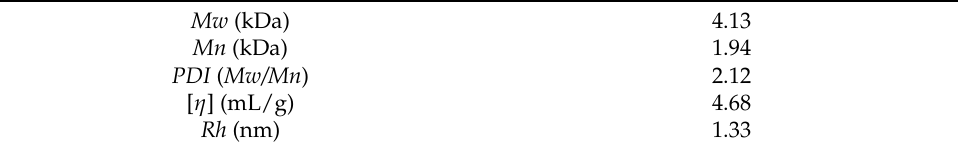
Table 2. Macromolecular characteristics of the CMSP from C. muelleri .